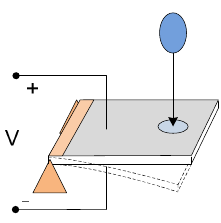
Figure 1. Piezoelectric cantilever: one edge is bound (orange one), the second is floating.